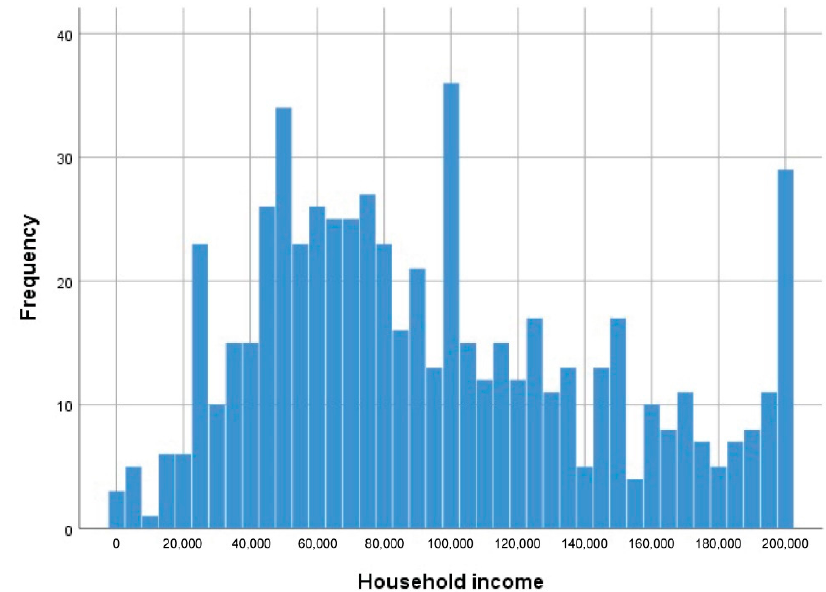
Figure 2. Income distribution of TNC-PEV drivers.